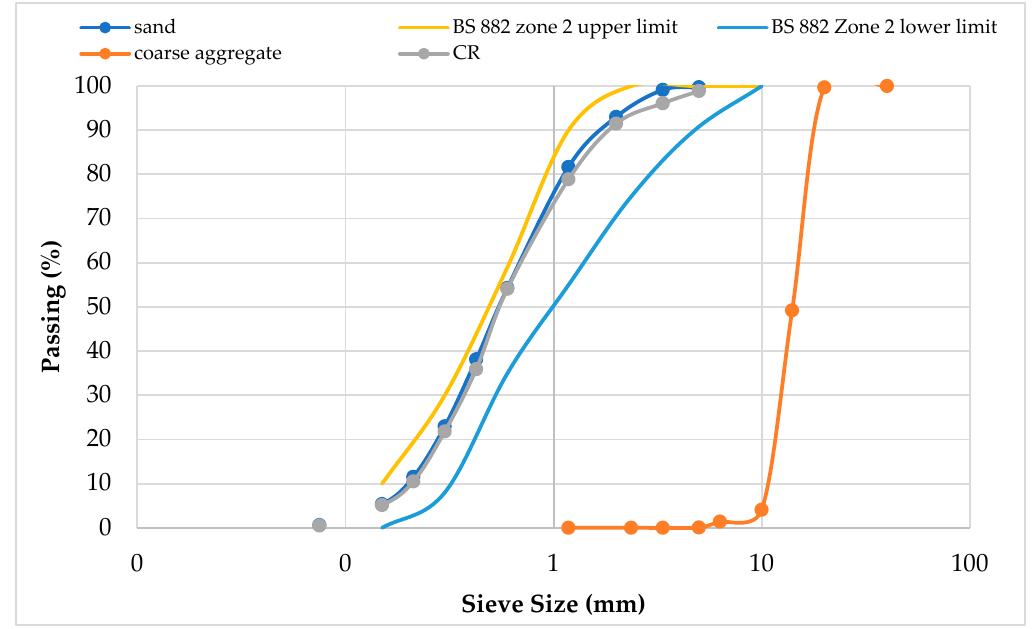
Figure 2. Aggregates gradation.